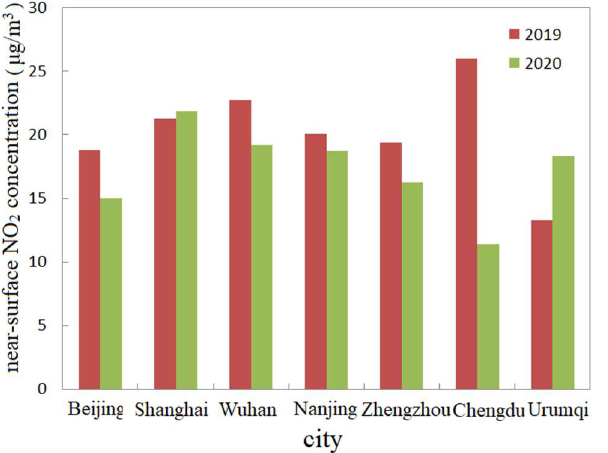
Figure 9. Near-surface NO 2 concentration comparison in seven typical cities in China between 1 to